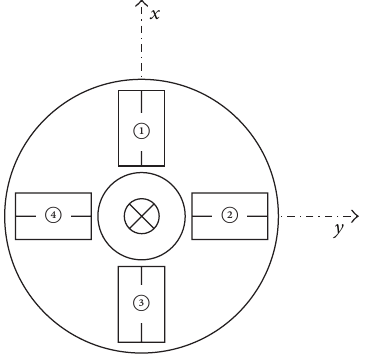
Figure 4: Control surfaces definition at bottom view.